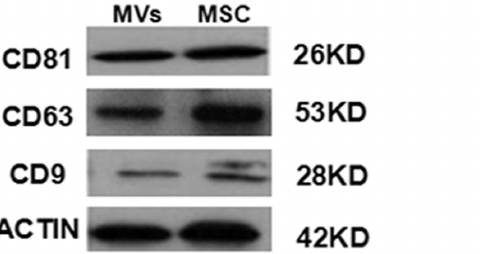
Fig 2. Western blot analysis on the expression of the exosomal markers CD63, CD81, and CD9 in MSCs and exosome-like vesicles.